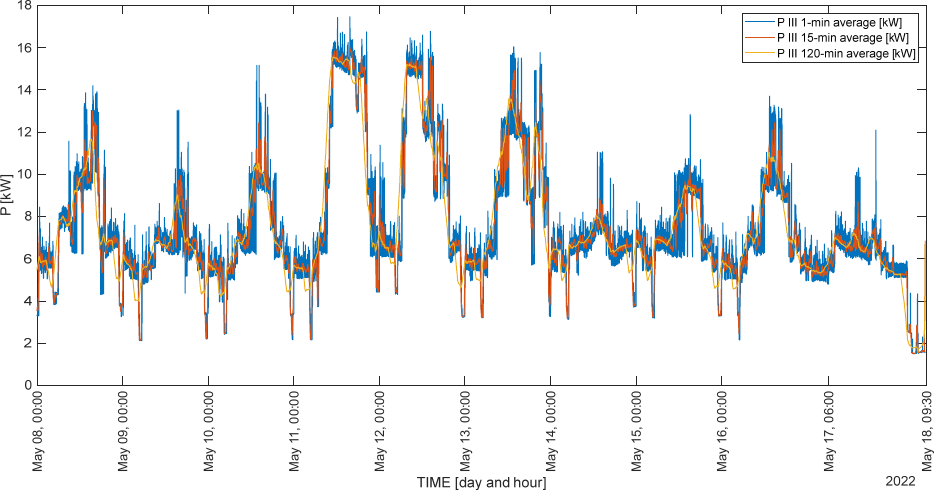
Figure 7. Three-phase active power as a function of time in the 3rd stage of the cycle.